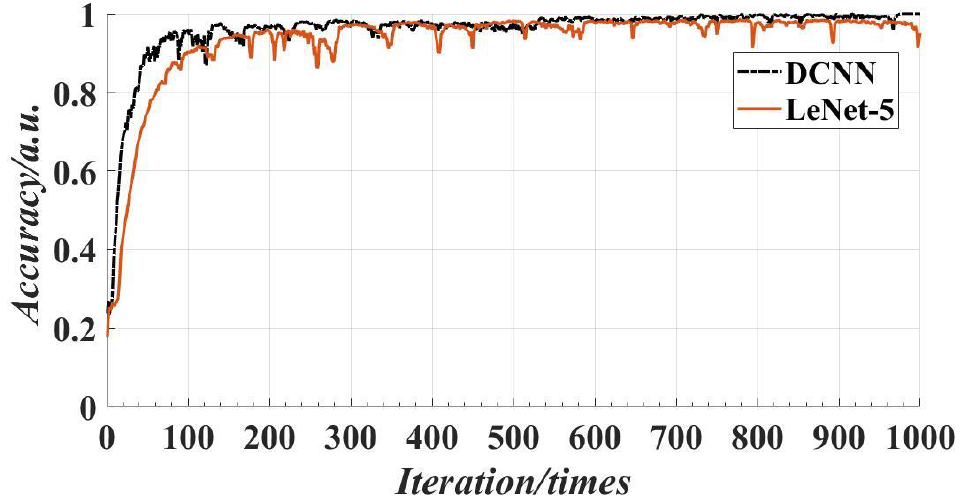
Figure 16. The accuracy of the two models with 1000 iterations.